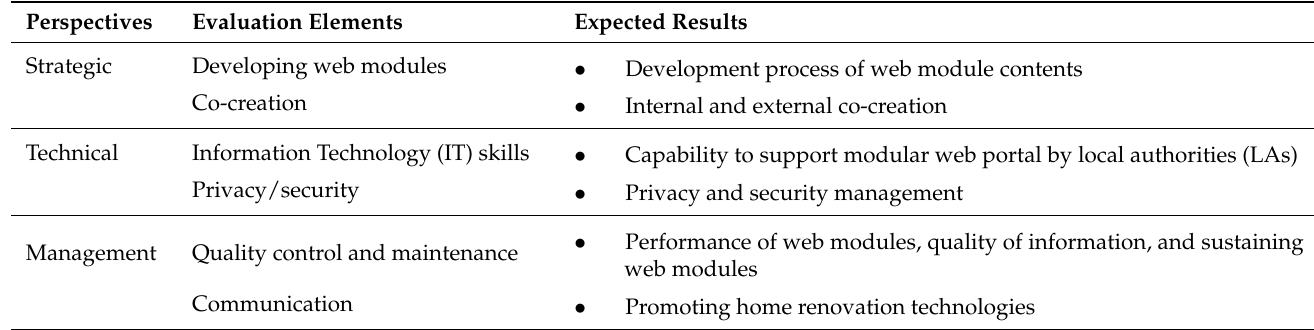
Table 1. Perspectives, overview of evaluation elements, and expected results for assessing local authority web portal